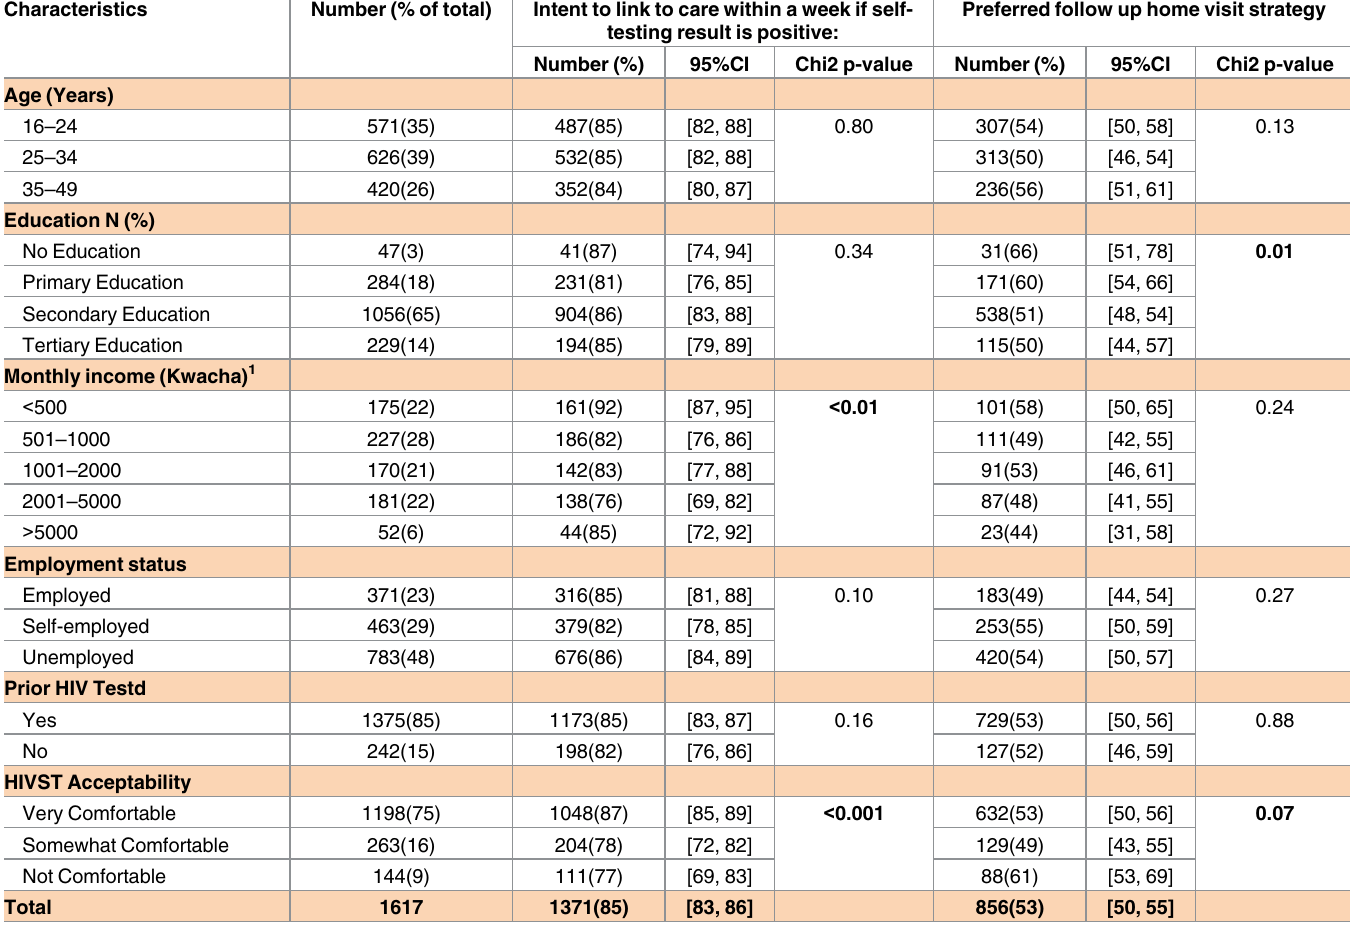
Table 2. Percentage of respondent aged 16–49 yearswho reported willing to link to care if HIV self-test result was positive and follow up strategy.